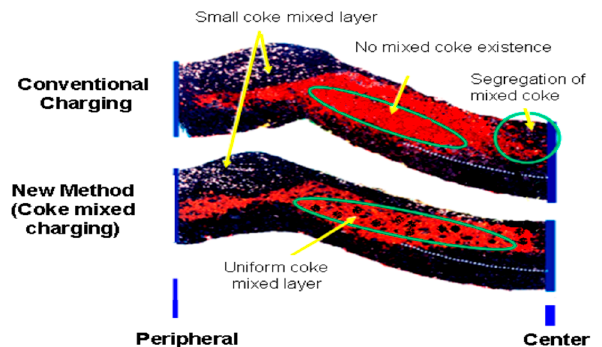
Figure 3. Comparison between conventional charging method and coke mixed charging method (adopted with permission from [85]).